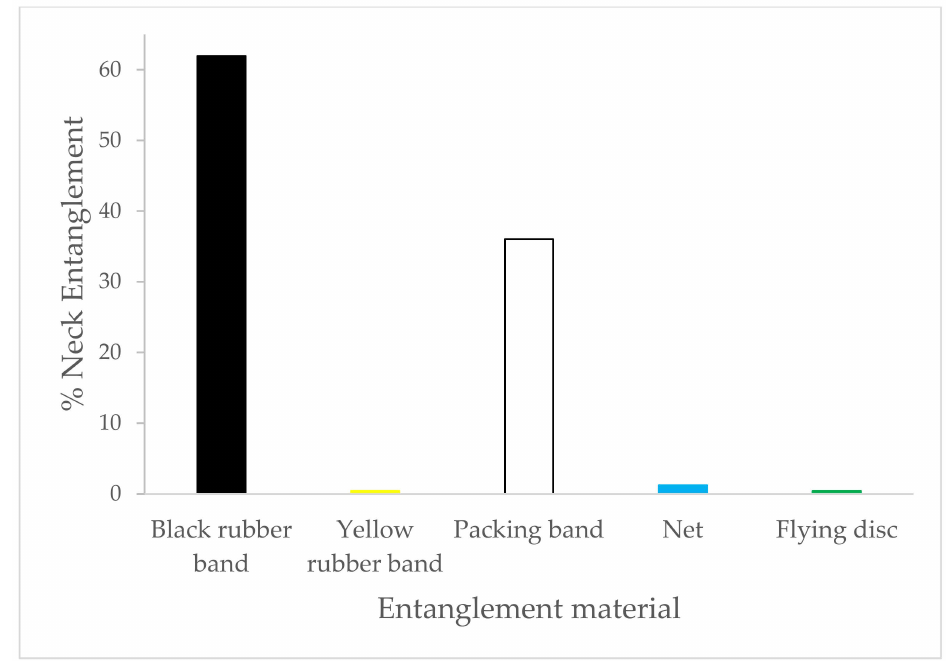
Figure 2. Percentage of identifiable Steller sea lion neck entanglements (n = 49) observed by en- tanglement type during surveys at Sea Lion Caves and Cascade Head haul-outs in Oregon during 2005–2009.